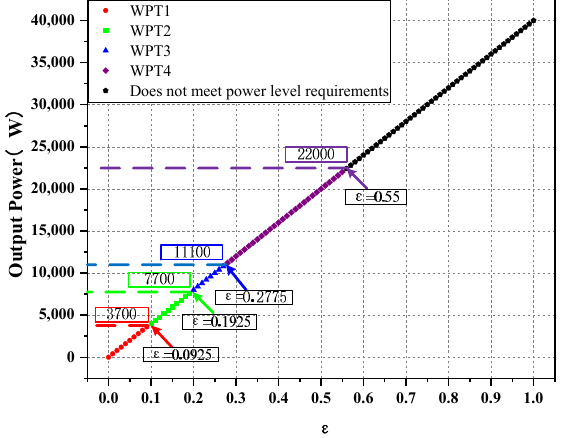
Figure 5. Relationship between system power characteristic impedance ε and transmission power P out .